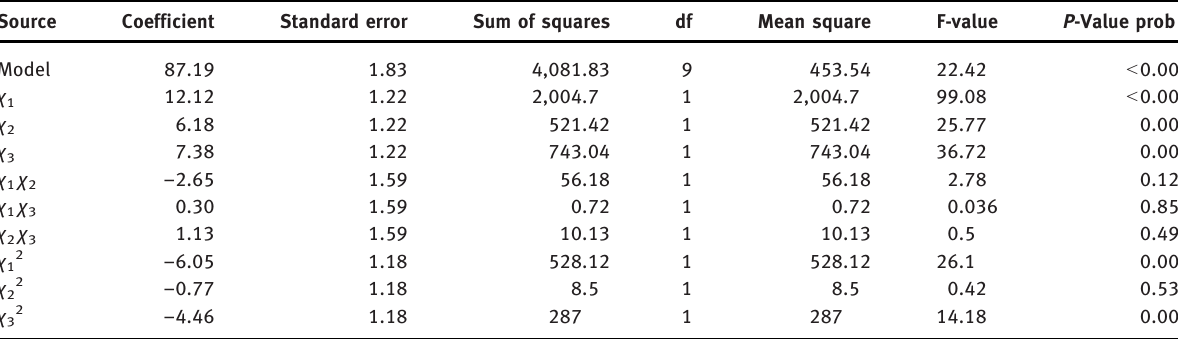
Table 6: Analysis of variance (ANOVA) for quadratic model.